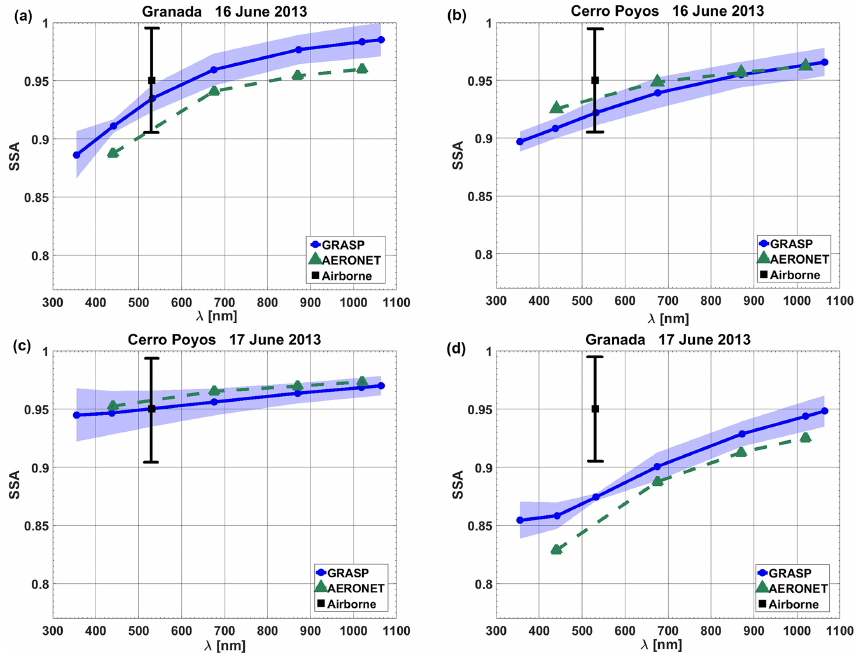
Figure 5. Single-scattering albedo retrieved by GRASP (blue) with its uncertainty (shaded area), by AERONET (green) and by airborne measurement (black) with its uncertainty on 16 (a, b) and 17 (c, d) June 2013 at Granada (a, c) and Cerro Poyos (b, d)